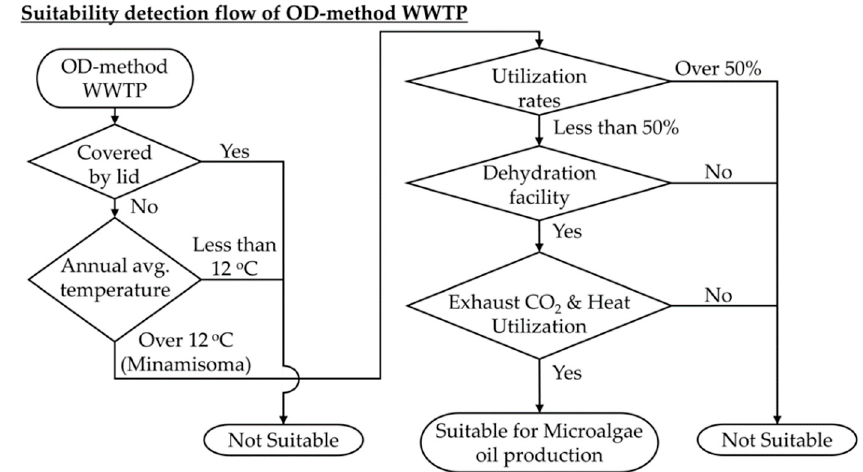
Figure 3. The suitability detection flow for the microalgae oil production using the oxidation ditch (OD) process without the need for new construction of reaction tank and sludge dehydrating facility.